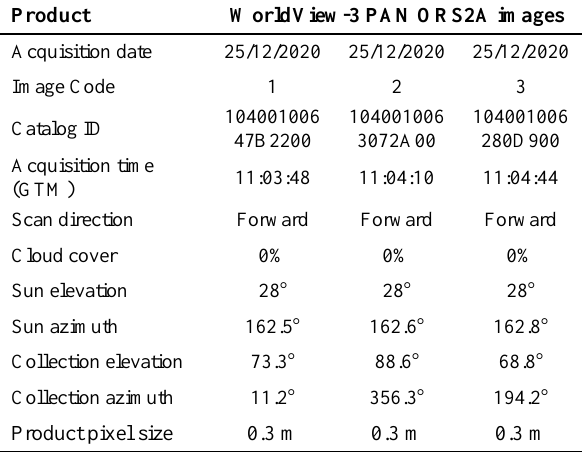
Table 1. Characteristics of WV3 PAN